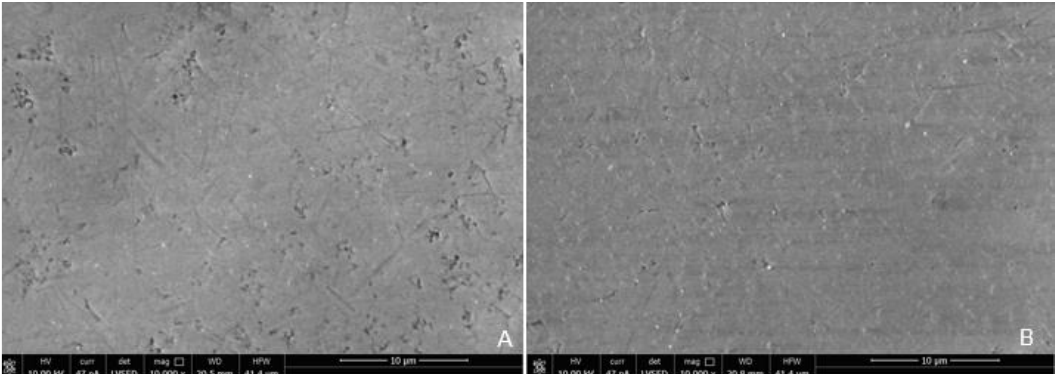
Figure 7. Scanning Electron Microscope Image of the Surface of the Zirconia crown at Magnification 10,000× Following Crown Removal with Rotary Handpiece ( A ) and Er,Cr;YSGG Laser ( B ).